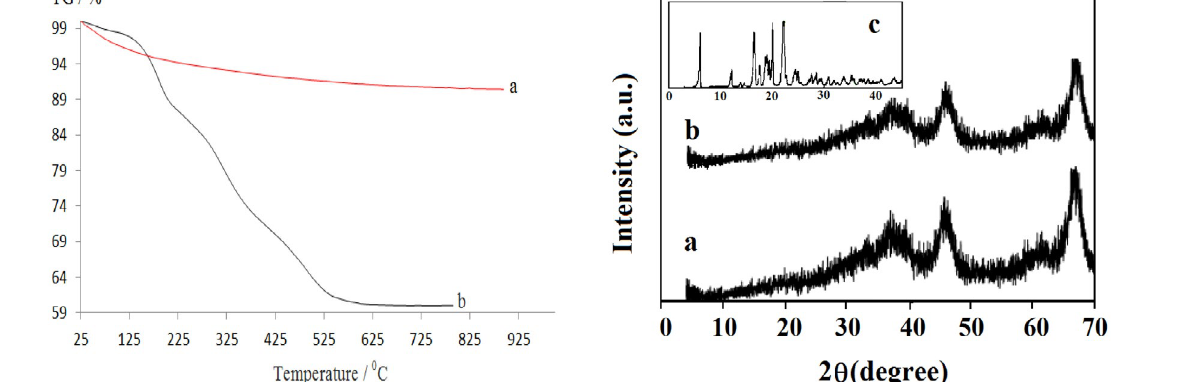
Fig. 3. TGA thermogram of (a) γ-alumina (γ-Al) and (b) 25% ibuprofen supported γ-alumina (γ-Al-IBU25)